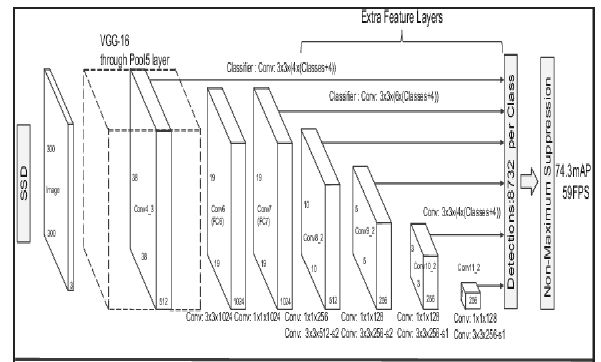
Figure 2.4. SSD Architecture